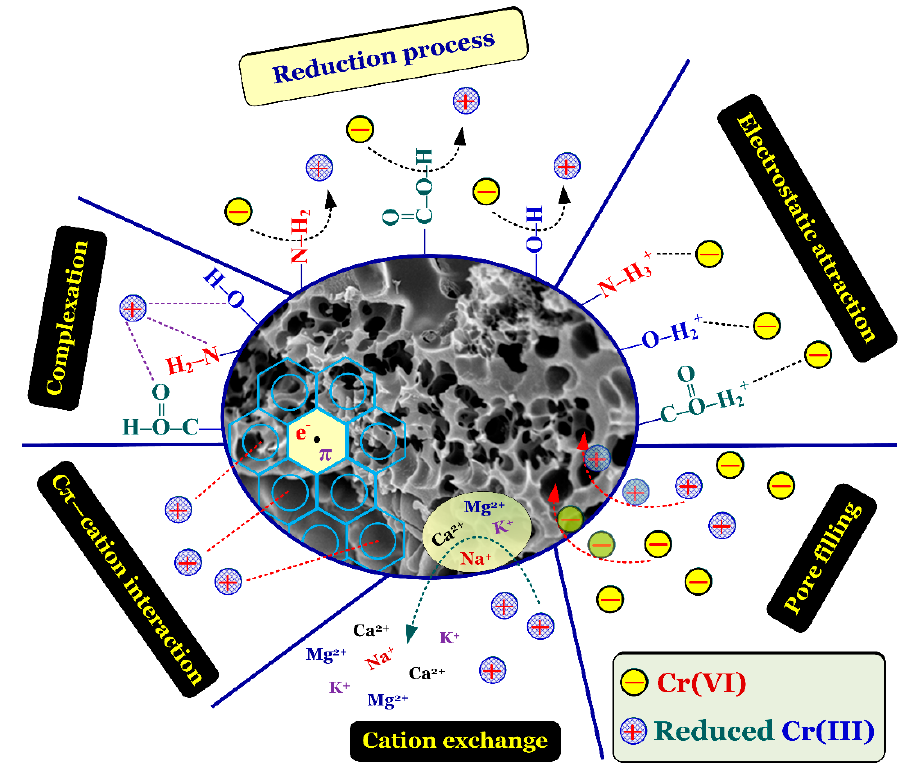
Figure 6. Proposed removal mechanism (adsorption-coupled reduction) of chromium by the carbonaceous porous materials